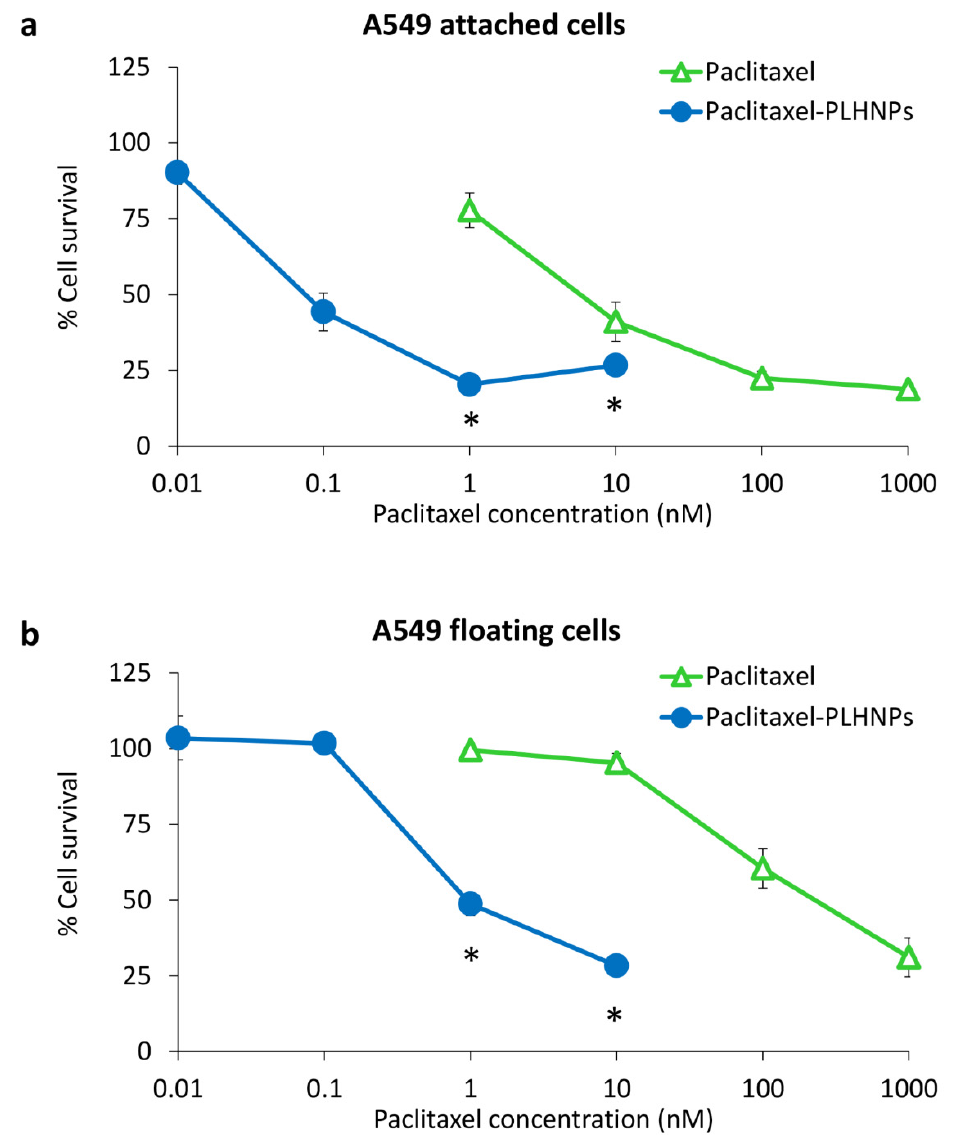
Figure 5. Relative survival rate (%) of ( a ) A549 attached cells and ( b ) A549 floating cells treated with paclitaxel and paclitaxel-PLHNPs. * p < 0.05 compared to free paclitaxel. Table 2. IC 50 values of paclitaxel in A549 attached and A549 floating cells. * p < 0.05 compared to free paclitaxel.